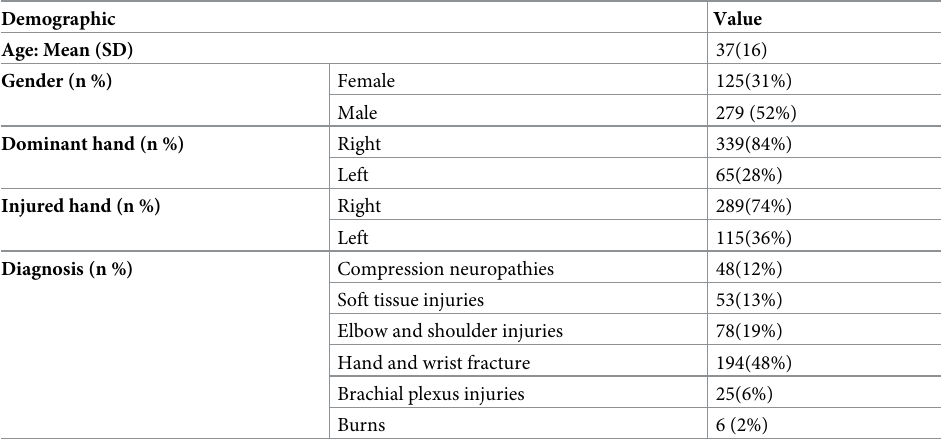
Table 1. Patients’ demographic characteristics (n = 404).